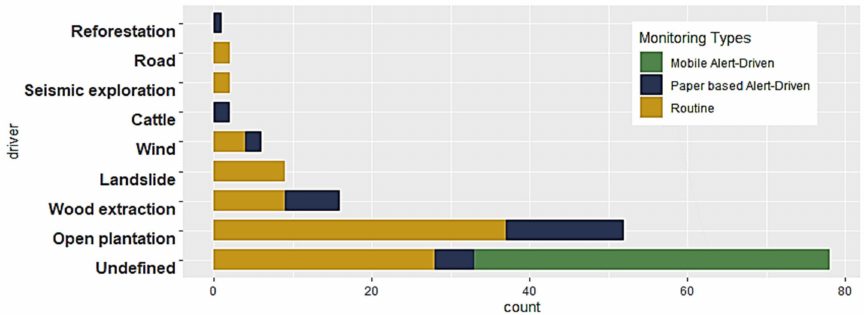
Figure 7. Forest change characterization based on routine and alert-driven field observations by communities.